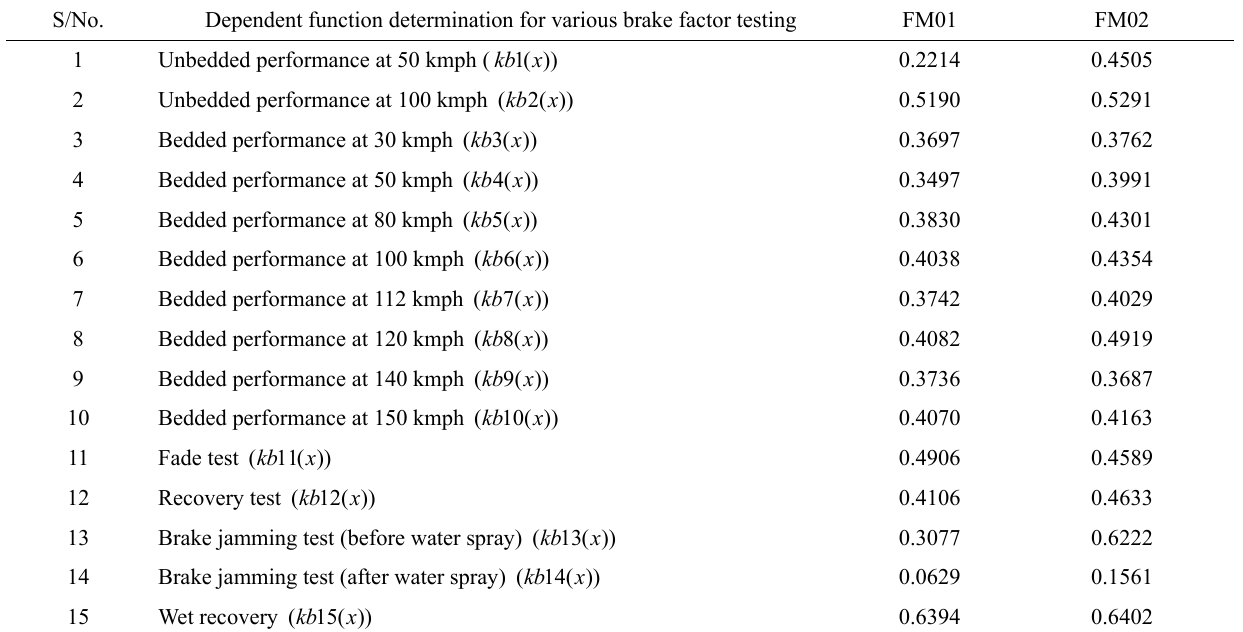
Table 5 Results of extensive evaluation of developed composites based on various friction (brake factor) testing.